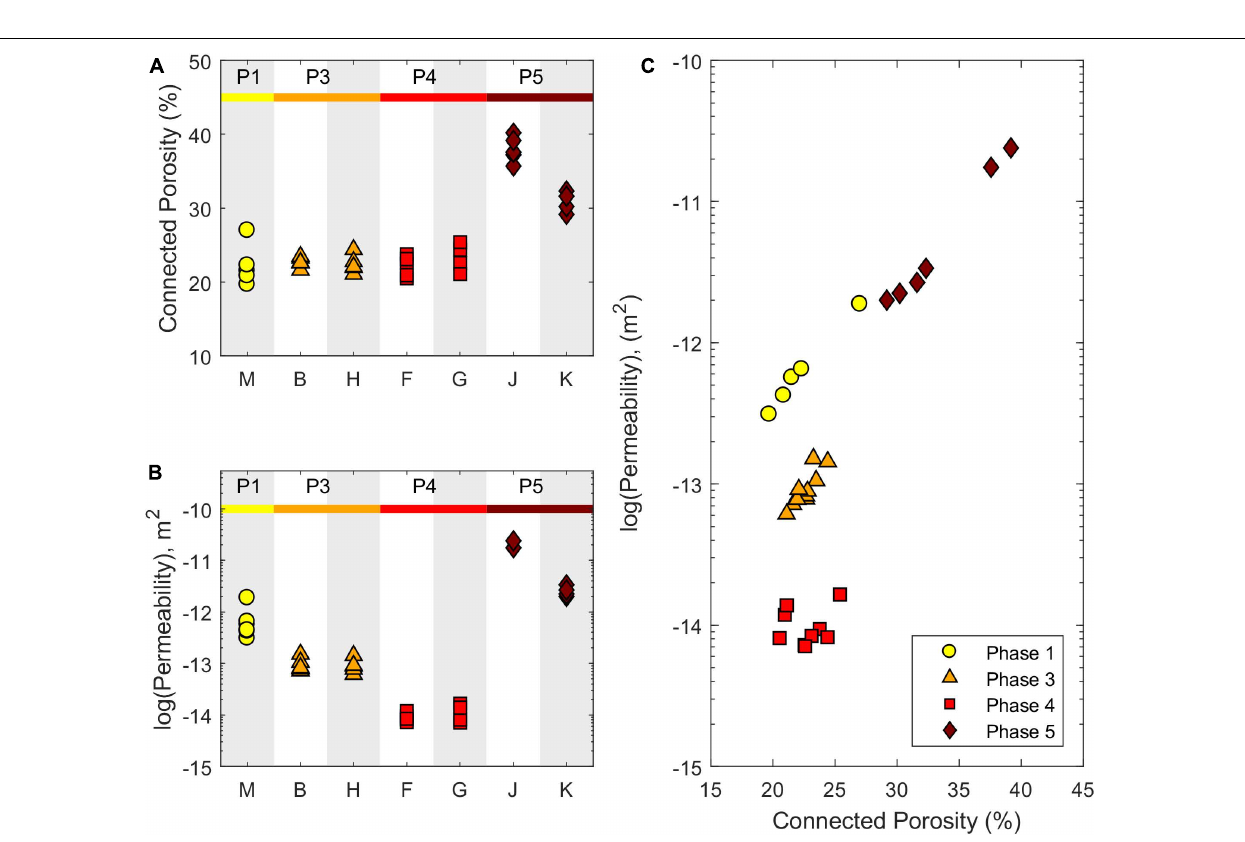
FIGURE 6 | Physical properties of 26 mm cores from eruptive Phases 1, 3, 4, and 5: (A) connected porosity evolution and (B) gas permeability evolution throughout the eruption; (C) permeability as a function of porosity for all samples. Results show that porosity is consistent between Phases 1, 3, 4, and increases in Phase 5, whereas permeability systematically decreases from Phase 1 through to Phase 4, and then increases in Phase 5. Phases 1 and 5 follow a near-continuous trend on the porosity-permeability plot, while Phases 3 and 4 plot distinctly, suggesting contrasting pore morphology and connectivity.